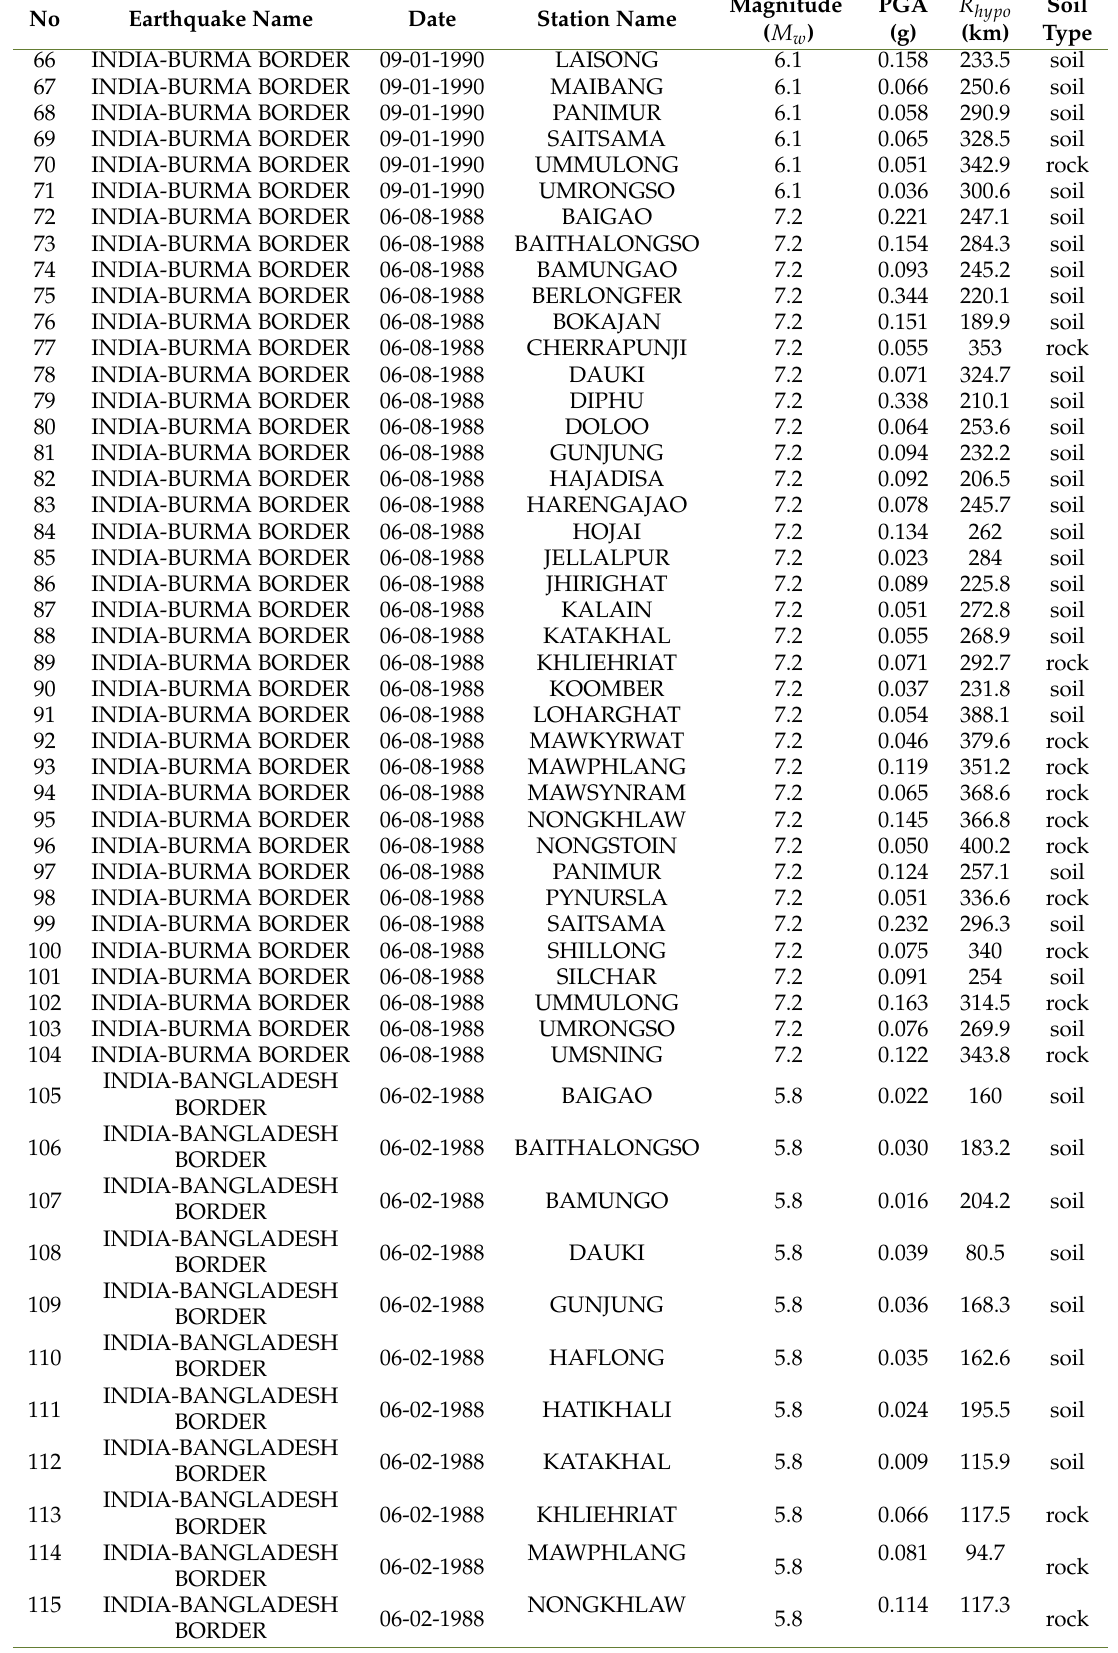
Table A1. Ground motions used in this study